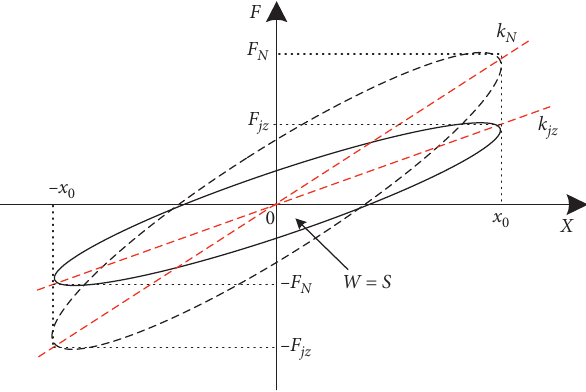
Figure 8: Dynamic hysteresis curve under different prepressures.